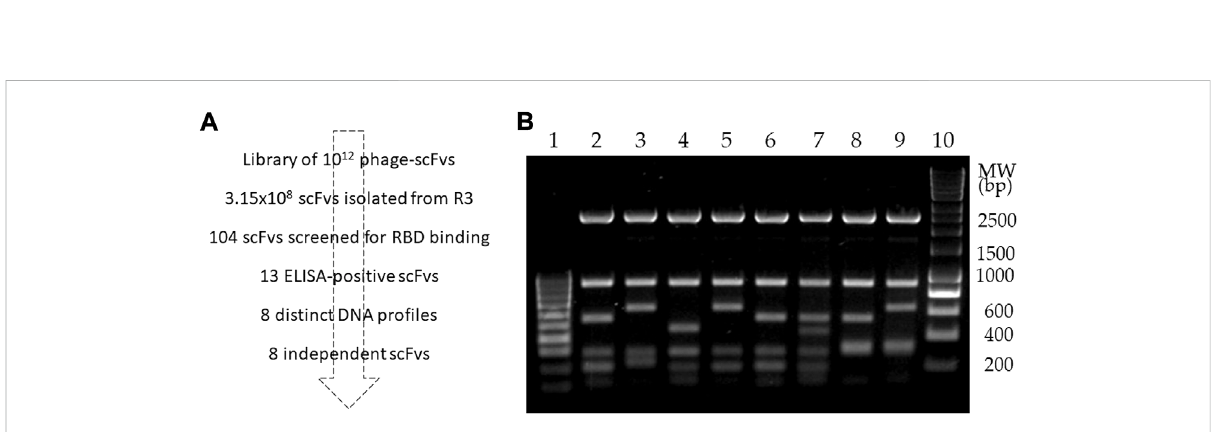
FIGURE 2 Isolation and DNA fi ngerprinting of RBD-binding scFvs. (A) Work fl ow showing isolation of RBD-binding scFvs. (B) Restriction pro fi le analysis of eightRBD-bindingscFvsisolatedfromlibraryscreening.Lanes:1,10:molecularweightmarkers;2 – 9: Bst NI-digestedDNAfromscFvs2,3,10,37,D4, E10, F11 and G12,